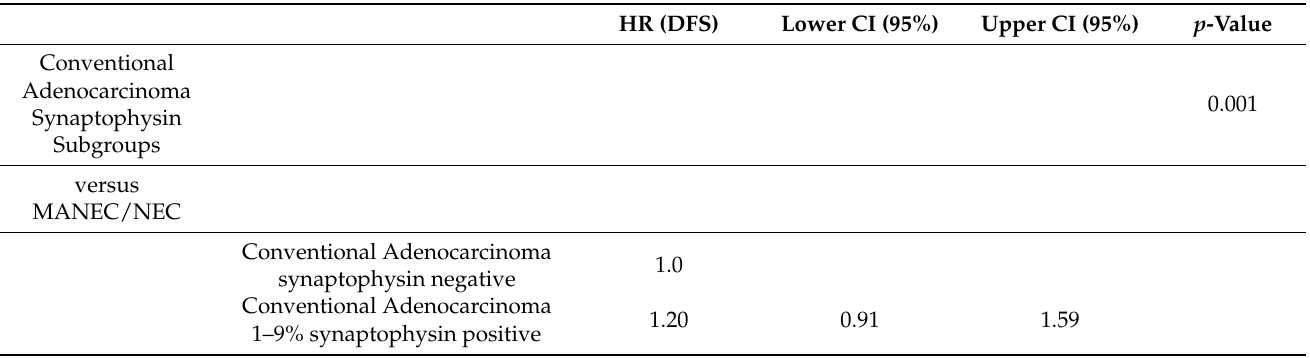
Table 3. Multivariate analysis for disease-free survival including synaptophysin expression groups in conventional adenocarcinomas with a non-neuroendocrine morphology compared to MANECs and UICC stage, WHO grade, age and sex. HR (DFS) Lower CI